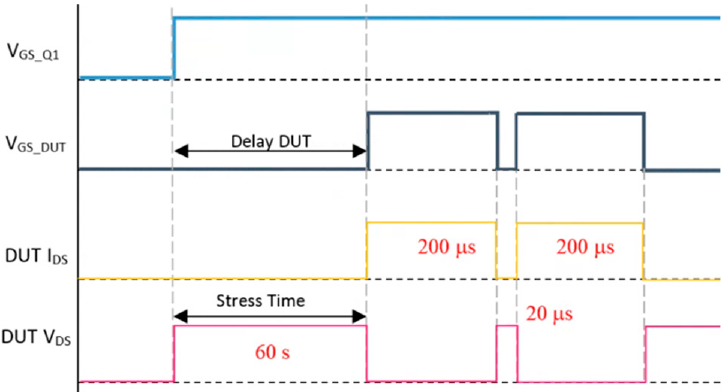
Figure 4. The gate voltage sequence for the double pulse tests.